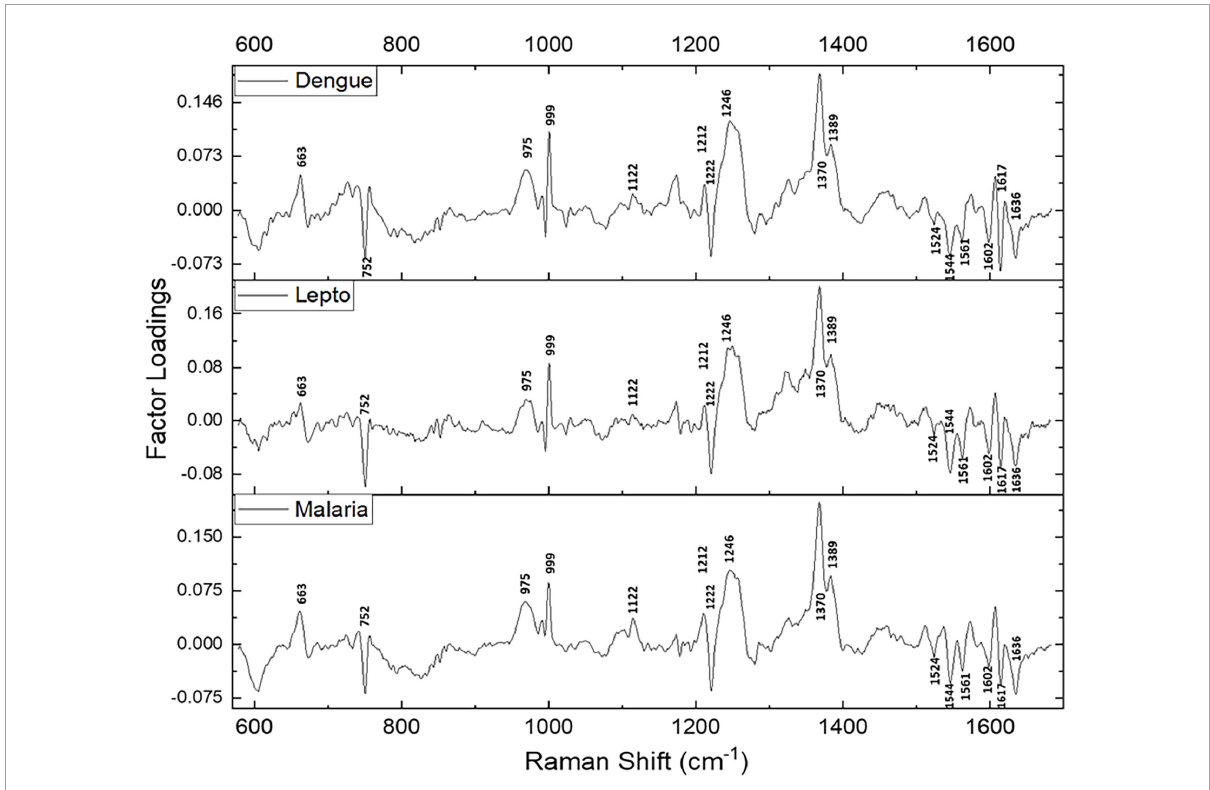
FIGURE4 Spectral loadings of the PC1 scores between RBCs of healthy and disease